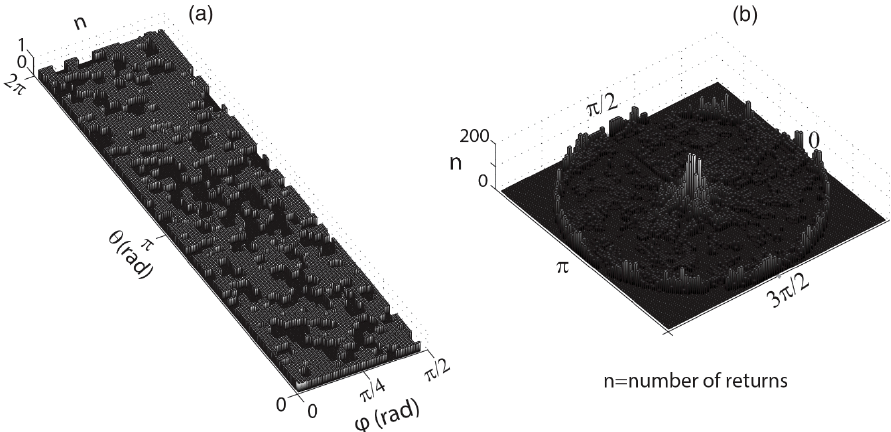
Figure 4. Simulated angular data with C gap pattern and 0.5 GF for the angular grid method ( a ) and for its hemispherical transformation ( b ).